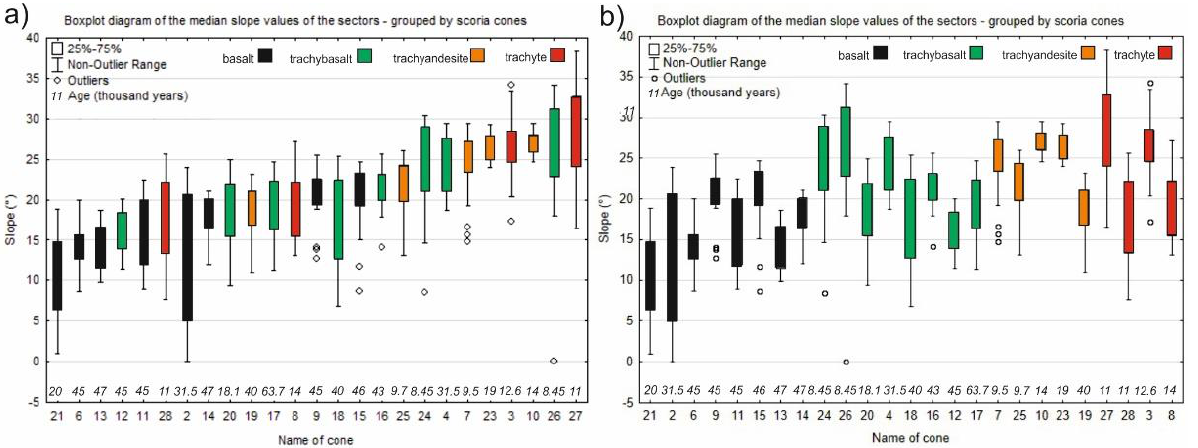
Figure 10. Boxplot diagrams of the median slope values of the sectors. Cones plotted according to ( a ) increasing median values and ( b ) according to lithology and then ages (black: basalt, green: trachybasalt, yellow: trachyandesite, red: tra- chyte).